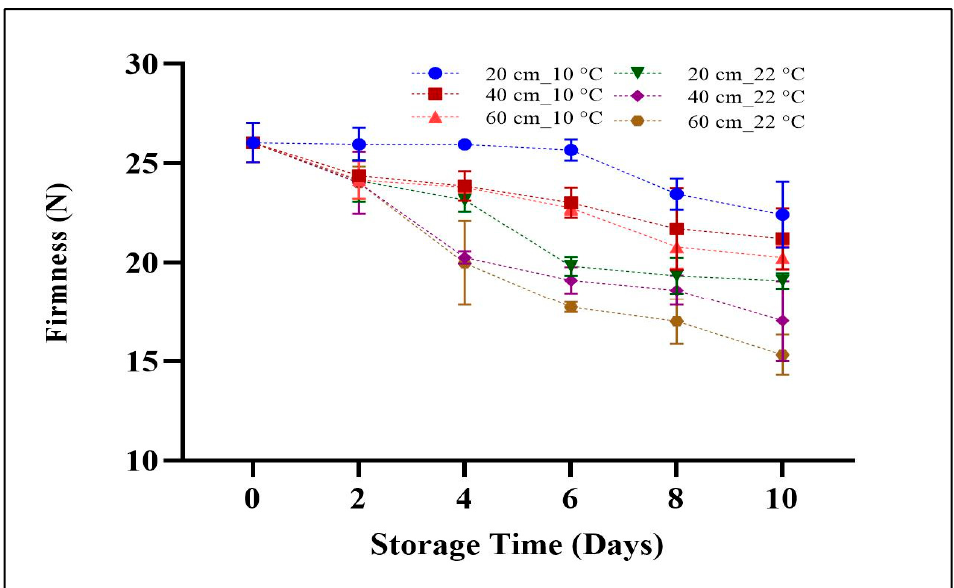
Figure 6. The firmness of tomato impacted at different drop heights (20 cm, 40 cm, and 60 cm) and stored for 10 days in 10 °C and 22 °C storage conditions. Error bars represent the standard deviation (SD) of the mean values ± S.D. of six readings of three replicates.